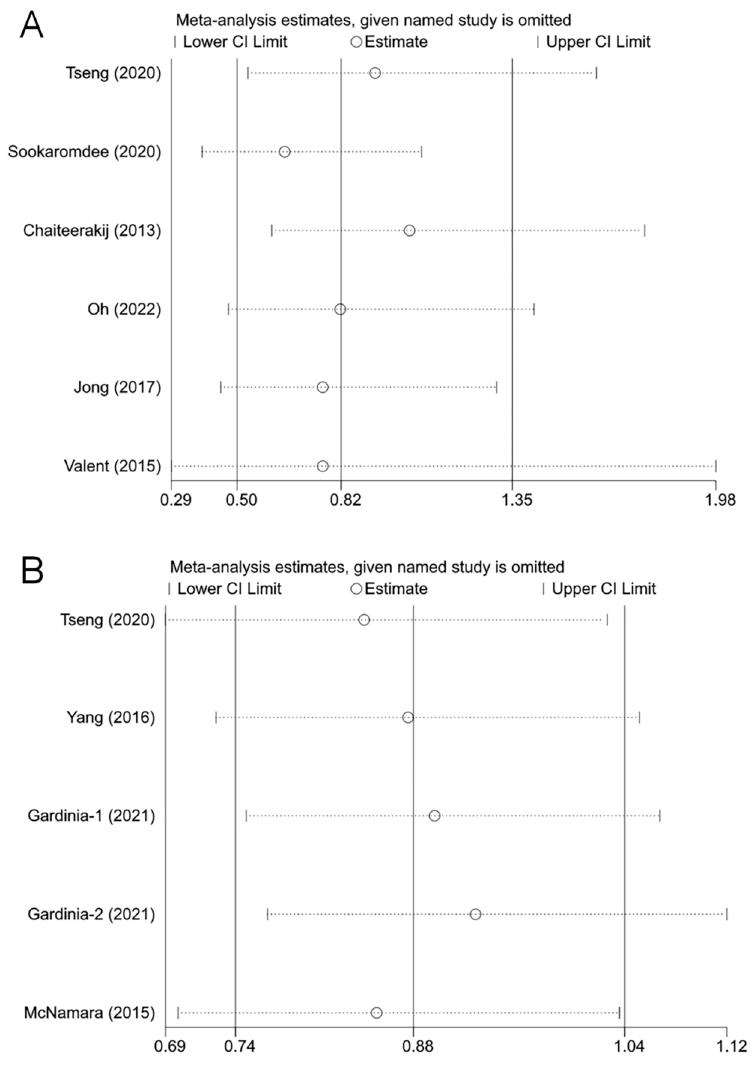
Figure 4. The effects of the individual studies on the pooled effect size: ( A ) biliary tract cancer risk [21,31,22,23,33,34]; ( B ) overall survival [21,24,30,35]. The horizontal axis is the scale of effect estimates. On the left side of the vertical axis are the studies that were excluded in turn; the corresponding effect estimates and confidence intervals on the right side are the results of the meta-analysis for all studies except for the excluded study in that row. A study was considered to have an excessive influence on the pooled results if the result of the re-analysis after excluding that study exceeded the confidence intervals of the overall meta-analysis. The effect sizes re-estimated after removing each study in turn did not change significantly, indicating that the current results are relatively stable.